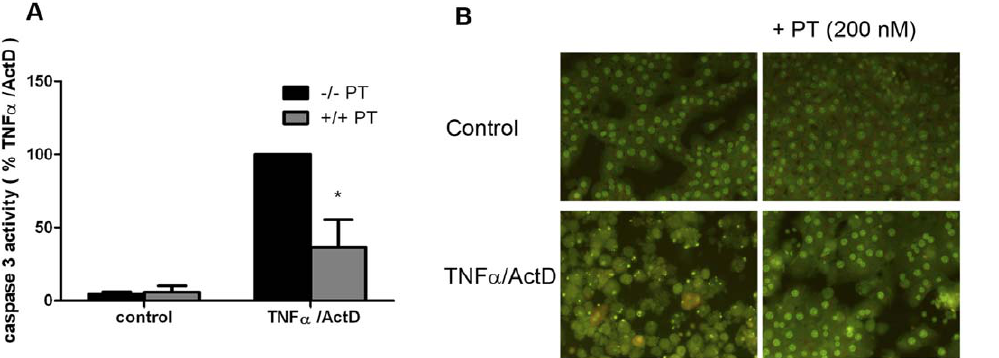
Figure 4. Pertussis toxin (PT) inhibits tumor necrosis factor- a /actinomycin-D (TNF a /ActD)-induced caspase-3 activity and nuclear fragmentation. ( a ) Primary rat hepatocytes were treated for 16 hours with 20 ng/ml of TNF a in the presence of 200 ng/ml of ActD. 200 nmol/L of PT was added 30 min prior to the addition of TNF a /ActD. * P , 0.05 for TNF a /ActD + PT vs. TNF a /ActD alone. ( b ) Acridine orange staining. Treatment with TNF a /ActD induces nuclear condensation and fragmentation which is blocked with 200 nmol/L